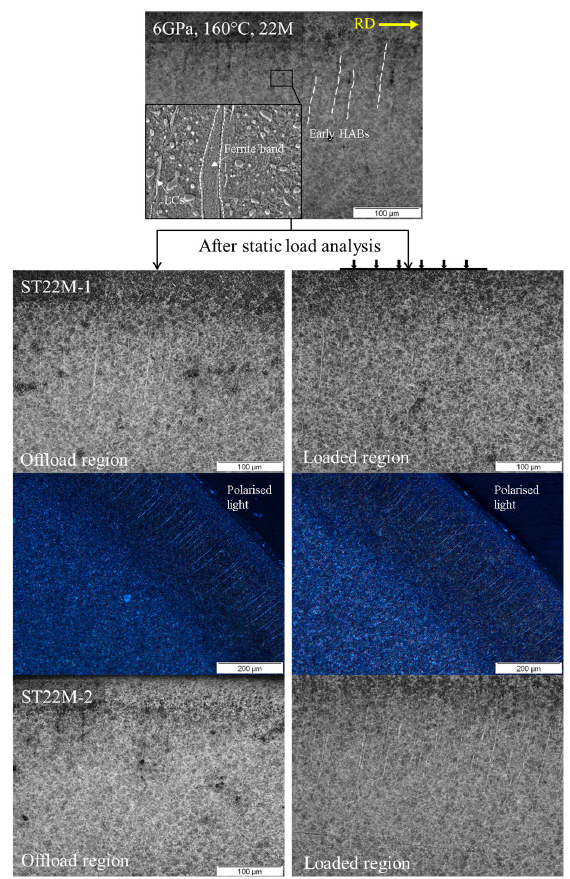
Figure 6. Circumferentially sliced micrographs obtained after 6 GPa, 160 °C, 22 M rolling cycles test, where the inset of figure shows microstructure of an early HAB. The loaded and offload regions of ST22M ‐ 1 and ST22M ‐ 2 are also shown after static load analysis. The high ‐ contrast images are acquired from cross ‐ polarised light.